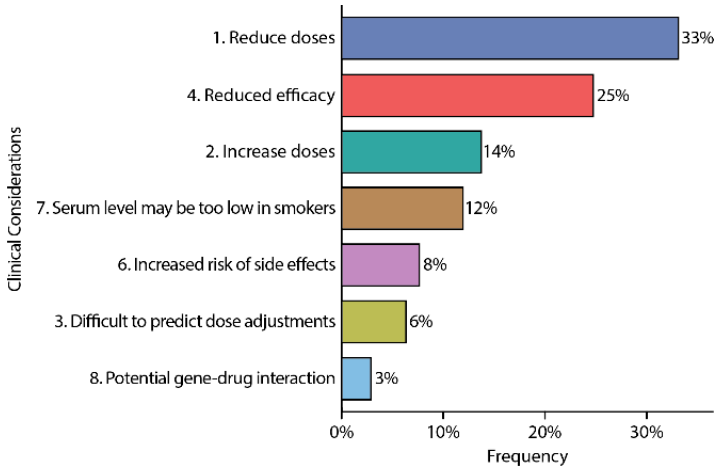
Figure 4. Frequency of clinical considerations. Of the types of gene–drug interactions, the most com- mon was a recommendation to reduce the dose due to decreased metabolism. The second most common was related to reduced efficacy due to metabolism or pharmacodynamic gene profile. A total of 3% had an important FDA label GDI.